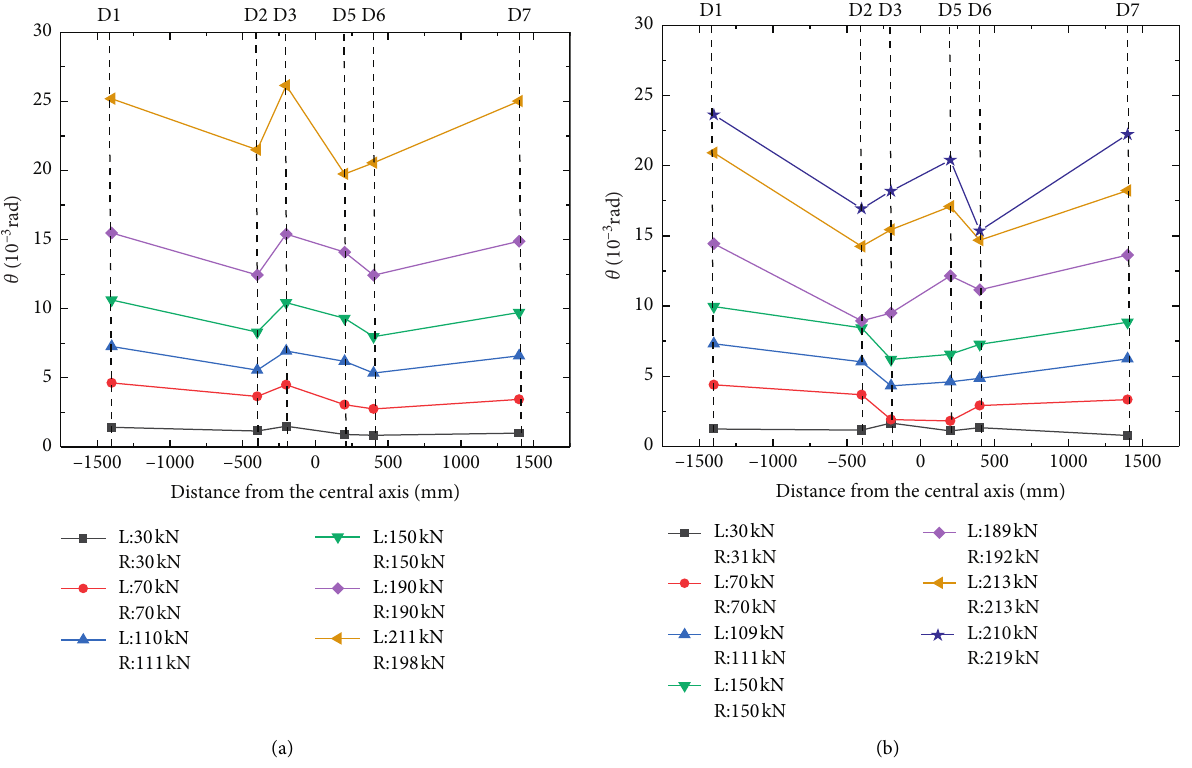
Figure 12: Chord angle-location curves. (a) BGJ1 and (b) BGJ2.